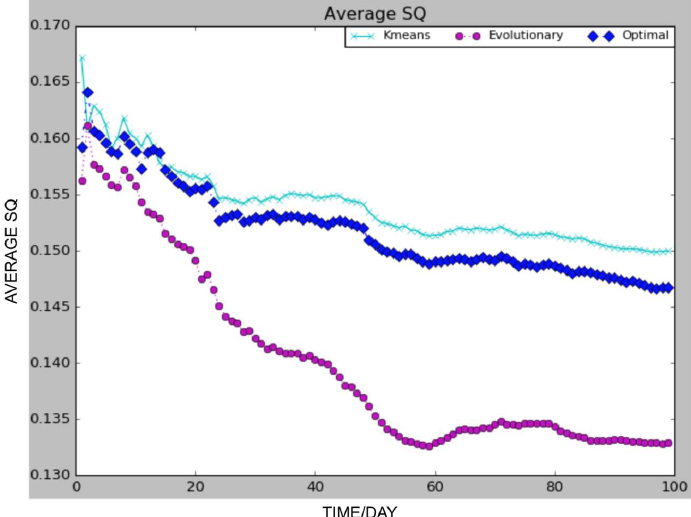
Figure 9. One hundred days’ average SQ of three algorithms in Shanghai dataset.